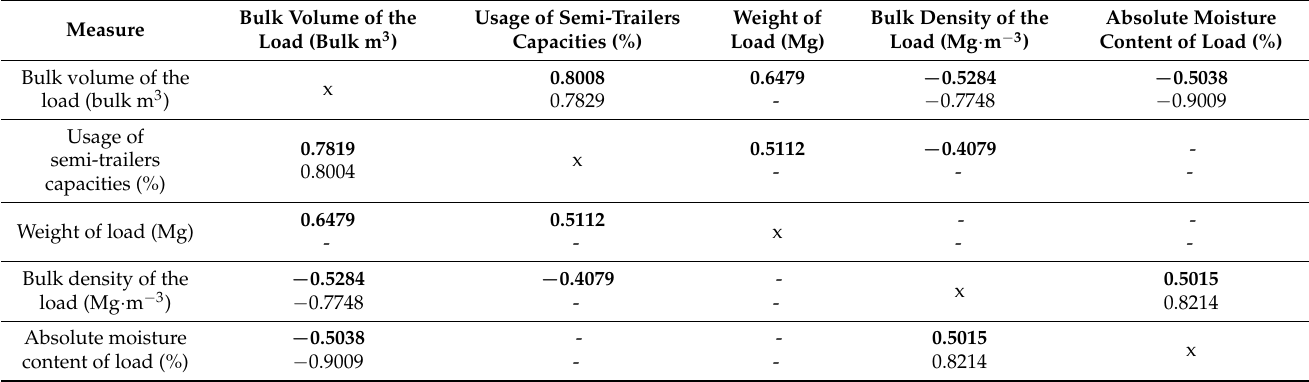
Table 8. Spearman’s correlation coefficients for the analyzed